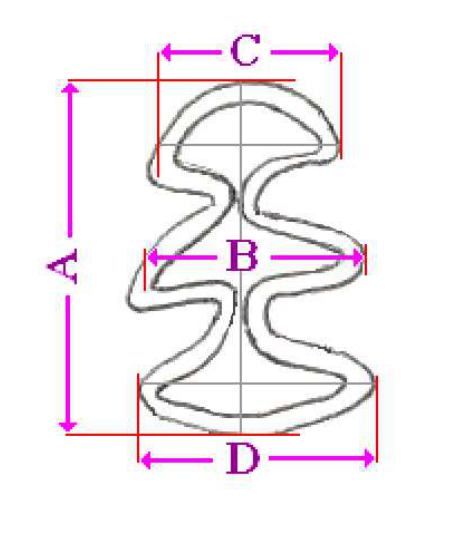
FIGURE 16 : The definition of measured characters on M/1 in Meriones